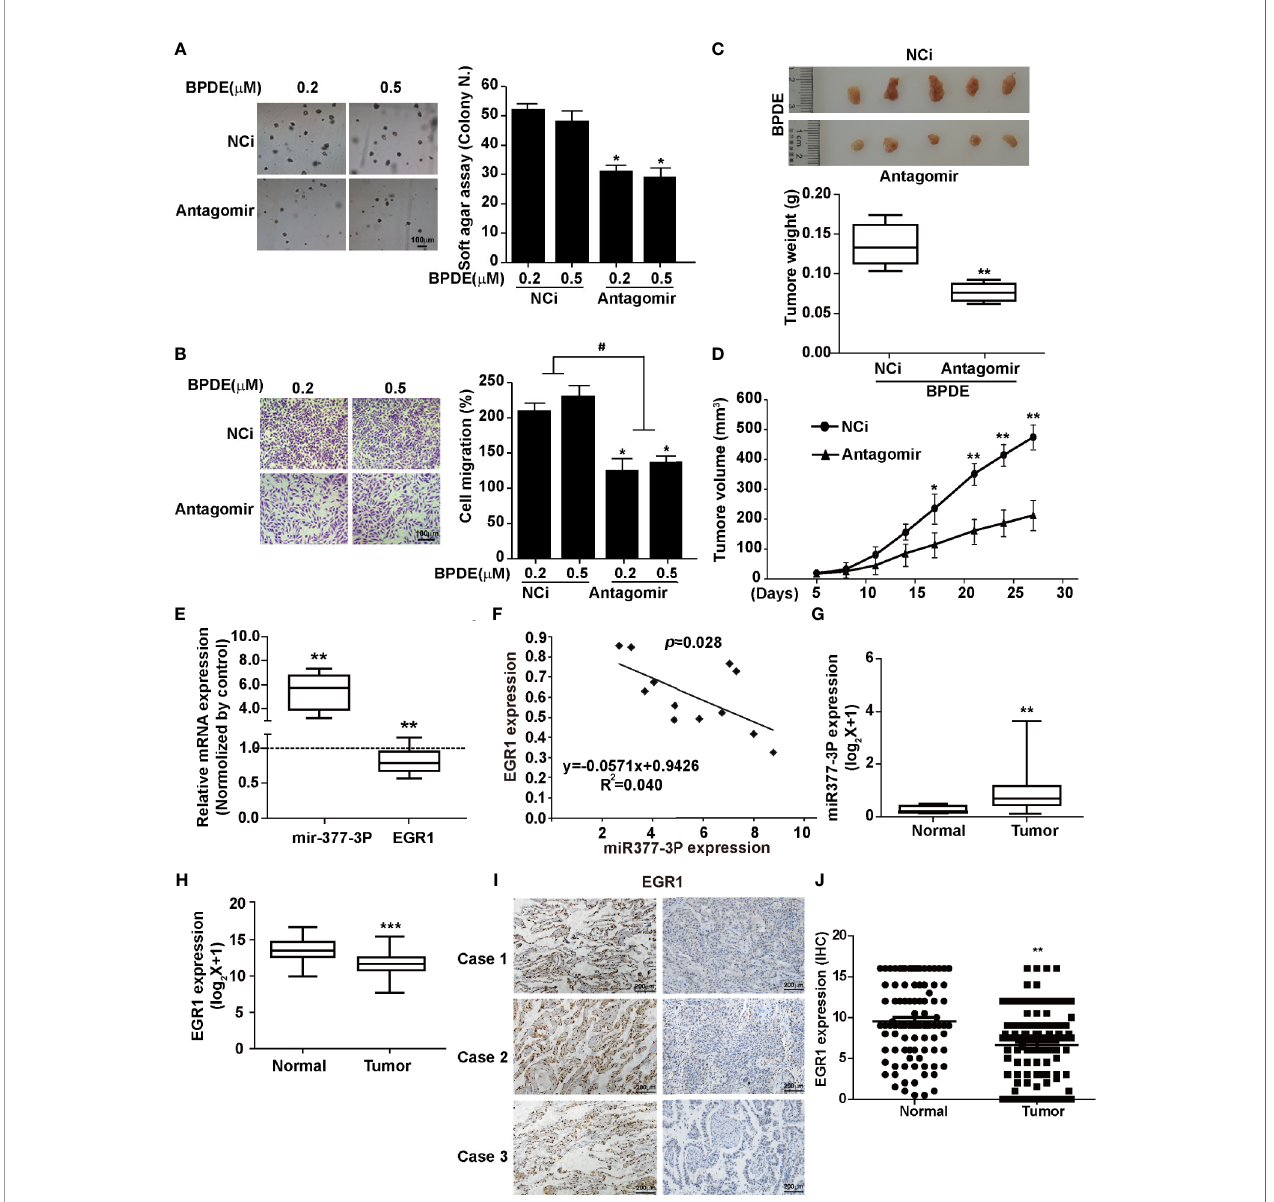
FIGURE 5 | MiR-377-3p antagomir rescued the effect of EGR1 downregulation in cell malignant transformation and lung carcinogenesis. (A) Soft-agar colony formation assays. Left, representative images; right, quantitative results of cell colony per fi eld. (B) Transwell migration assays. Left, representative images; right, quantitative results of migratory cells per fi eld. (C) Representative xenograft tumor images at 4 weeks after inoculation (top) and tumor weight (bottom) of BPDE- induced transformed cells treated with miRNA-377-3p antagomir or control. (D) The tumor growth curve of xenograft. (E) MiR-377-3p expression and EGR1 mRNA expression in B[a]P-induced murine lung cancer tissues by qRT-PCR. The analyses were repeated three times, and the results were expressed as mean ± SD. (F) The correlation analysis of EGR1 and miR-377-3p mRNA expression in mice carcinogenesis model. Y-axis showed EGR1 mRNA expression; X-axis showed miR- 377-3p mRNA expression. (G, H) TCGA database analysis of miR-377-3p expression and EGR1 mRNA expression in human lung adenocarcinoma tissues. (I) Representative image of IHC staining of EGR1 in human lung cancer tissues. (J) Quanti fi cation of EGR1 staining in the adjacent normal lung epithelial cells and lung cancer cells in 114 paired patient tissues. # ,* P < 0.05, ** P < 0.01, and *** P <